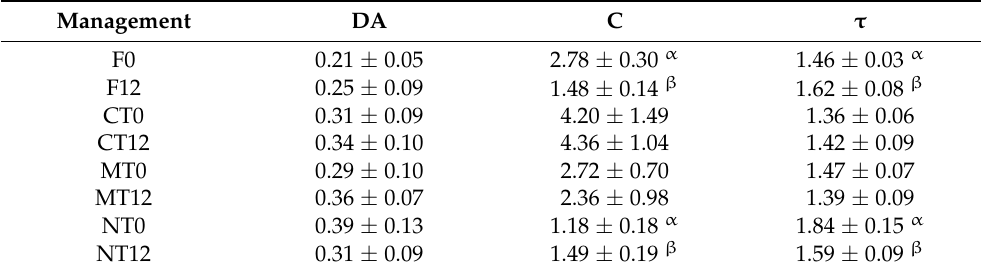
Table 3. Geometric parameters associated with the soil pore system of the secondary forest (F) and the three management practices (conventional tillage—CT, minimum tillage—MT, and no tillage—NT) submitted to 0 and 12 wetting and drying (W-D)